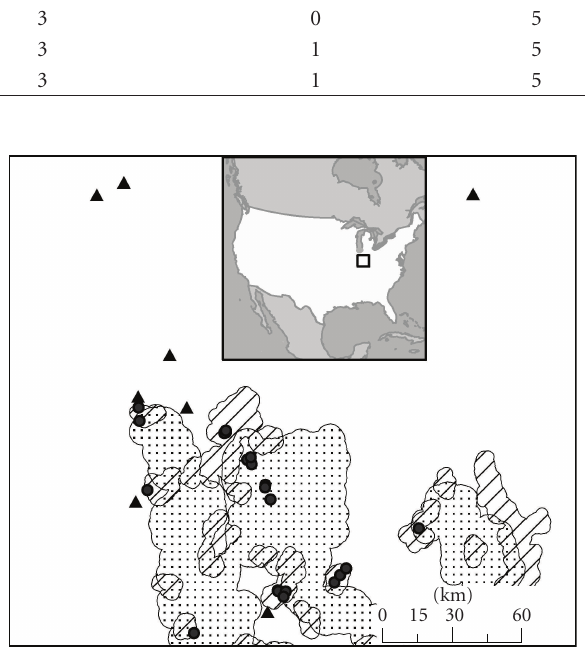
Figure 2: Map of southern Indiana, U.S.A. showing results of surveys in area of predicted new range boundary. Stippled and diagonal-hatched areas are predicted range; stippled, 4,800 m from 16,384 ha forest; diagonal-hatch, 2,500 m from 1,024 ha forest that intersect cross-hatched area; circles, larval scars detected; triangles, larval scars not detected. Inset: study area within Indiana,